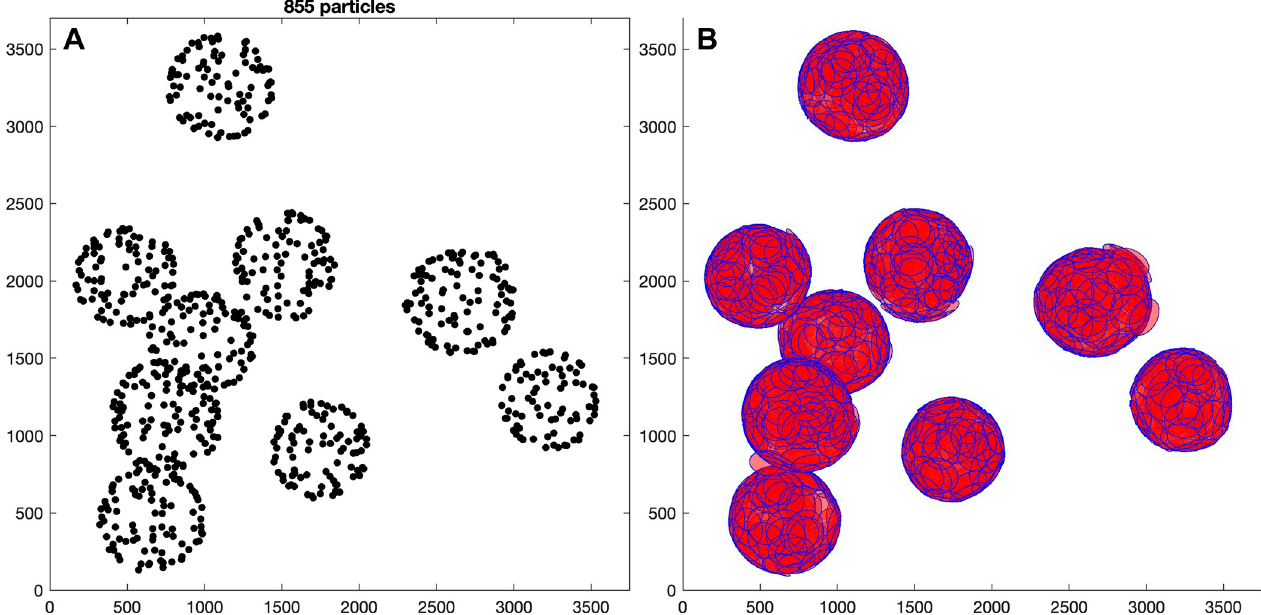
Fig 4. Results of first alignment. The left plot shows the coordinates of tomogram ts001 (z-view) visualized with the Dynamo command dtplot using the resulting table from the first alignment. The coordinates moved from their initial positions (compare Fig 2) and adapted to the shape of the VLPs. The cropped subvolumes are large enough to cover all the empty spaces between the coordinates. This is visualized in the plot on the right where disks with a diameter matching the side length of the subvolumes (256 pixels) are placed at each coordinate and successfully cover the whole surface of the VLPs (visualized using the Dynamo command dpktbl.plots.disks). The data and commands to exactly reproduce this figure are available on EMPIAR (EMPIAR-10702). EMPIAR, Electron Microscopy Public Image Archive; VLP, virus-like